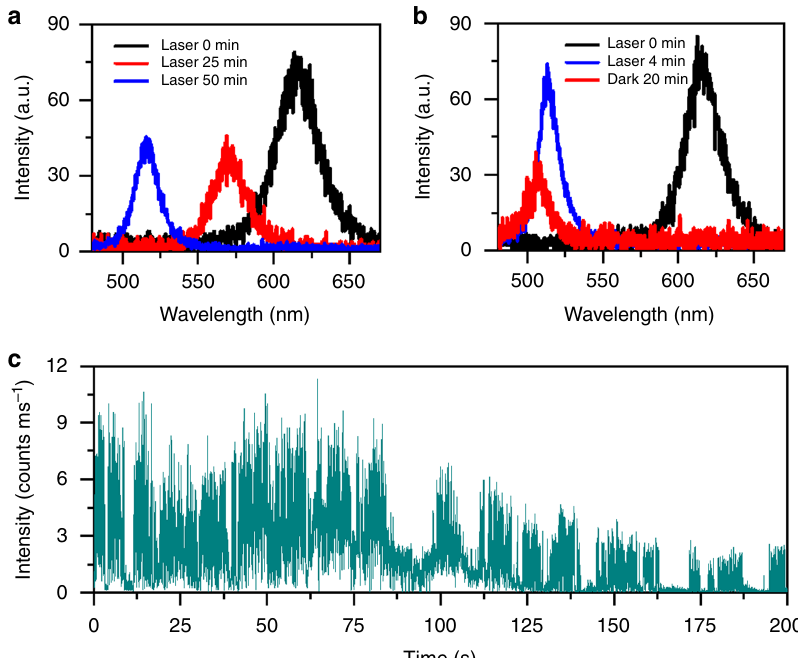
Fig. 2 Light-induced phase segregation in single CsPbBr 1.2 I 1.8 nanocrystals (NCs). a Photoluminescence (PL) spectra measured at three time points of 0, 25, and 50 min with an integration time of 1 s for a single CsPbBr 1.2 I 1.8 NC continuously excited at a laser power density of 6 W cm − 2 . b PL spectra measured at two time points of 0 and 4 min with an integration time of 1 s for a single CsPbBr 1.2 I 1.8 NC continuously excited at a laser power density of 6 W cm − 2 . Then after the excitation laser beam had been blocked for 20 min, a PL spectrum was taken with an integration time of 1 s for this single NC also excited at 6 W cm − 2 . c Time-dependent PL intensity measured between 20 and 220 s for the single CsPbBr 1.2 I 1.8 NC whose PL spectra are plotted in b and continuously excited at 6 W cm − 2 . The binning time for acquiring each data point for the PL intensity is 100